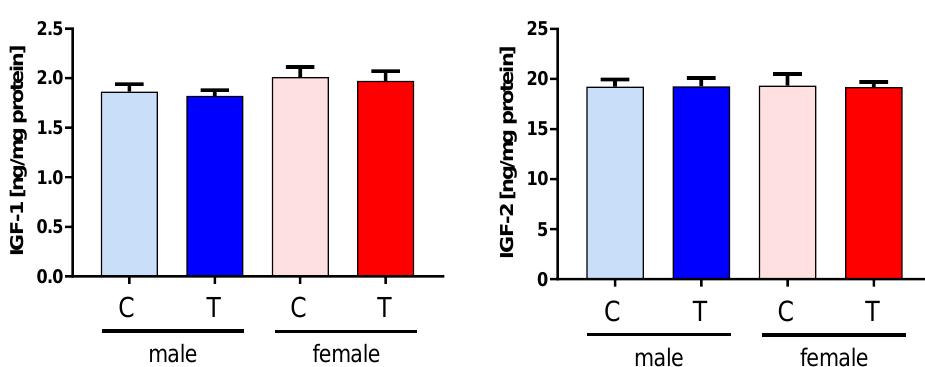
Figure 4 . Concentrations of IGF-1 (left panel) and IGF-2 (right panel) in muscle extracts from male (blue) and female (red) IGFBP-2 transgenic (T) mice and non-transgenic (C) littermates (DU6P/C57BL/6). The concentrations of both peptide hormones were quantified by ELISAs as described in Section 2 (mean ± SEM; age: 7 weeks; n = 10).